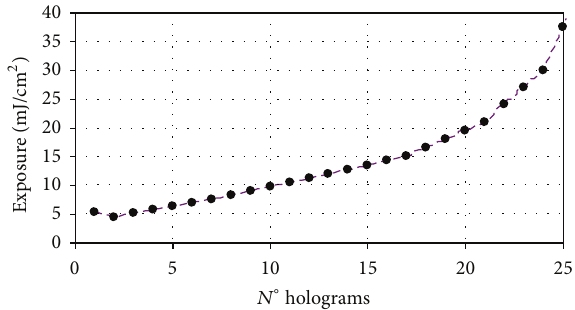
Figure 1: Exposure with which the objects of Figures 2 and 3 are recorded in the